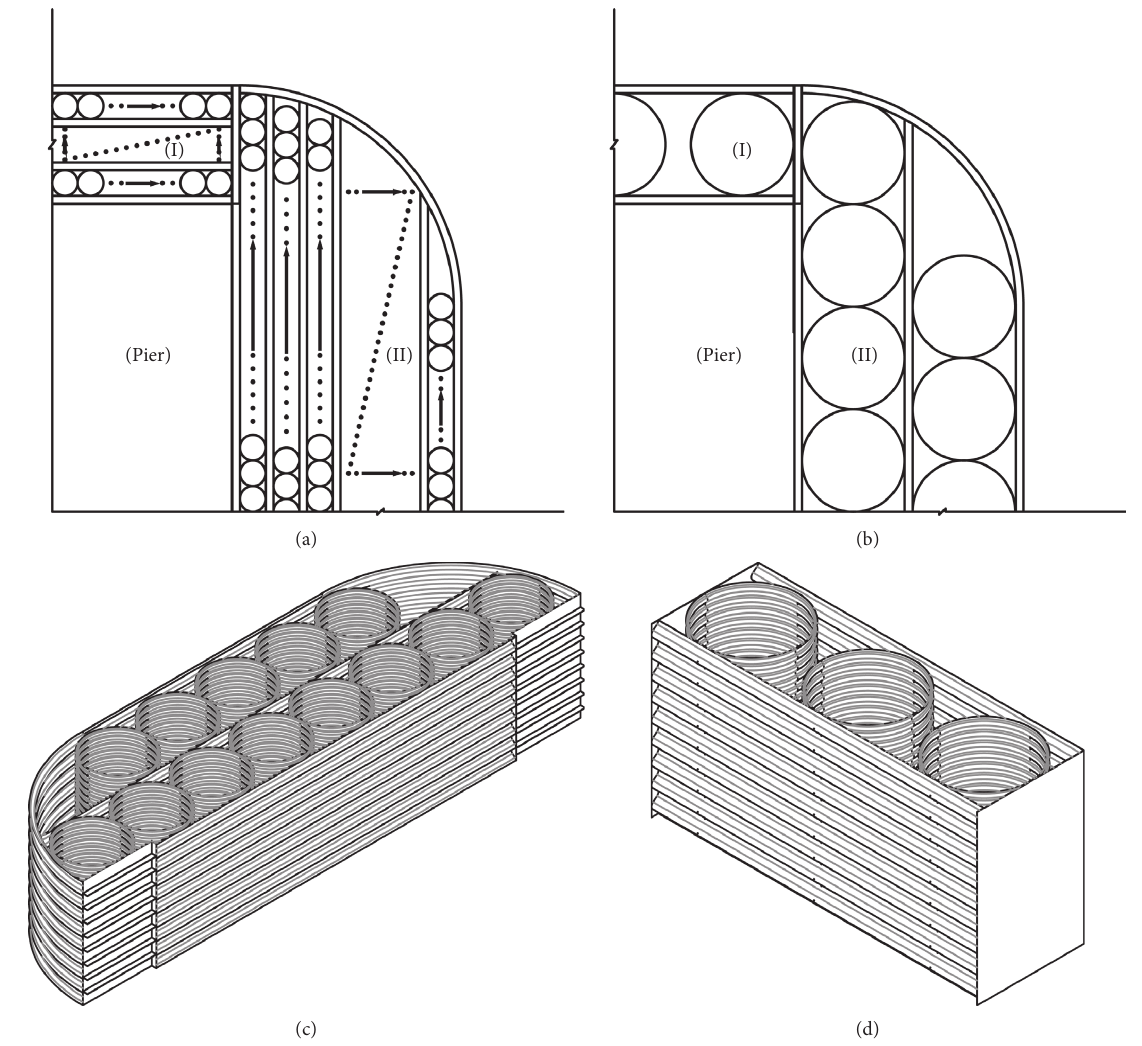
Figure 1: Schematic of the CSP structure: (a) complex structure of CSP, (b) CSP structural type used for research, (c) left and right side modules, and (d) front and rear